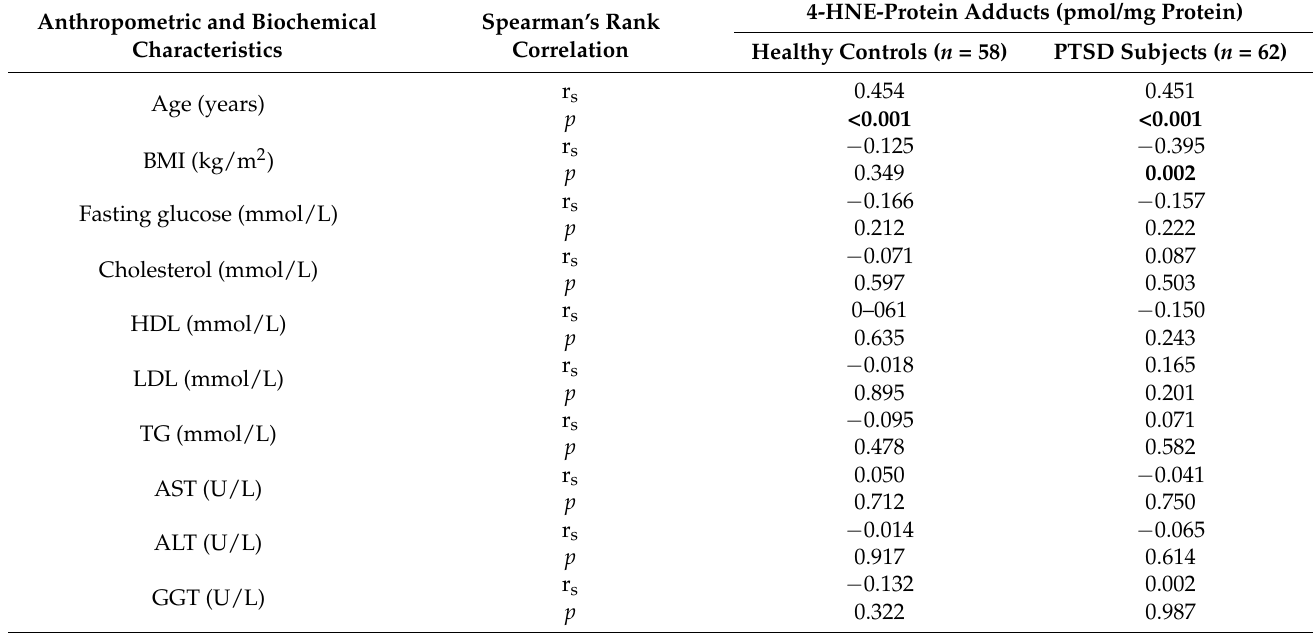
Table 2. Correlation of 4-HNE-protein adducts concentration (pmol/mg protein) with different anthropometric and biochemical characteristics of healthy controls and patients with PTSD. Spearman’s rank correlation was used to test the potential significant relationship between different parameters.